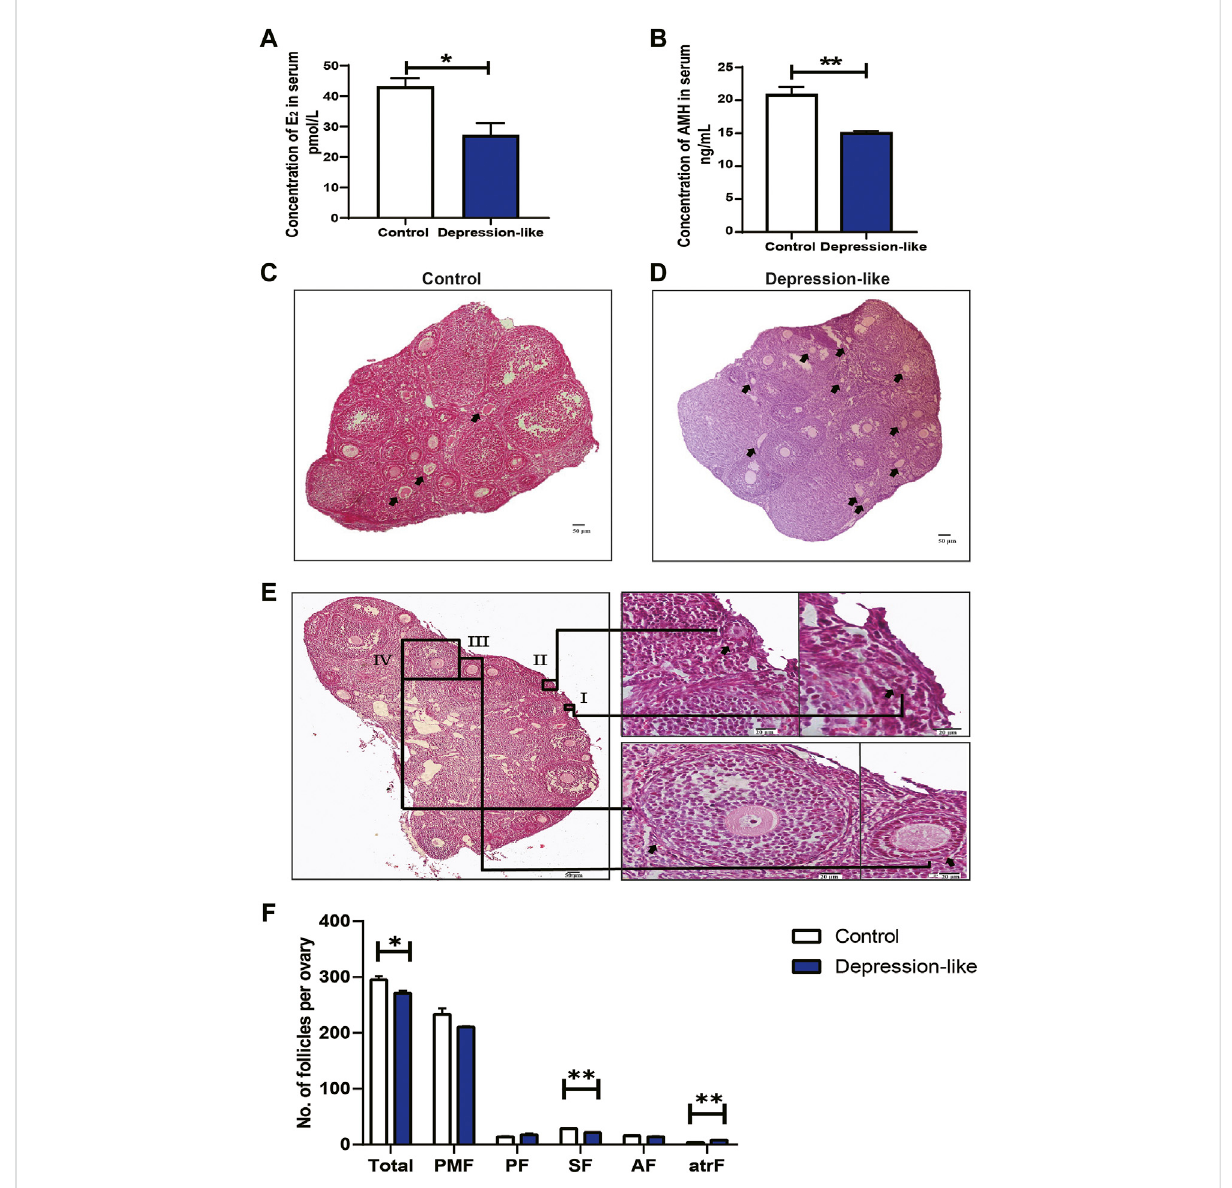
FIGURE 2 Quanti fi cationofovarianfolliclesandmeasurementofserumhormonelevels. (A) Seracollectedfromcontrol( n =4)anddepression-like( n =3) mice for hormone levels. Signi fi cantly reduced levels of E 2 were observed in depression-like mice. (B) Signi fi cantly reduced levels of AMH were also observed in depression-like mice. (C,D) H&E staining of total ovarian sections of control ( n = 3) and depression-like mice ( n = 3). Prematurely active follicles that underwent atresia were noted (arrow). (E) H&E staining of typical morphologies of different-stage follicles. I, primordial follicle; II, primordial follicle, III, primary follicle; IV, secondary follicle; V, antral follicle. (F) Quanti fi cation of follicles in mouse ovaries of the control and depression-like groups. Abbreviations: total follicles (Total), primordial (PFM), primary (PF), secondary (SF), early antral (AF), and atretic follicles (atrF). Scale bars, 50 and 20 μ m (enlargements) (** p < 0.01; * p <